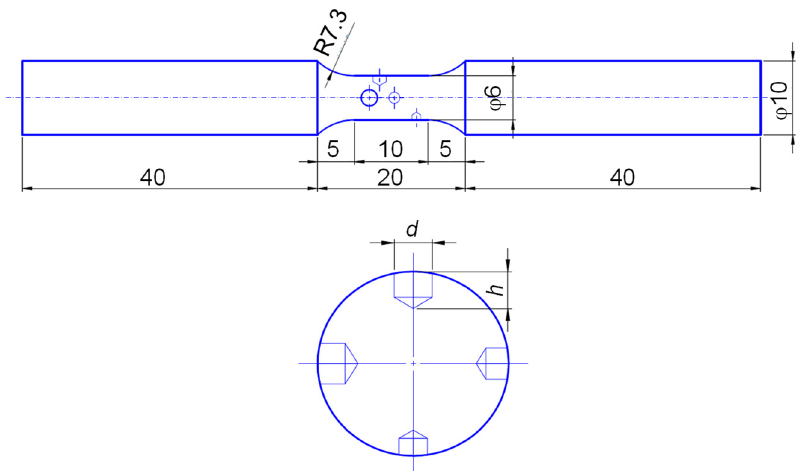
Figure 1. Fatigue specimen configuration with drilled artificial defects. Dimension is in mm. Table 2. Sizes of artificial defects of specimens I, II and III.